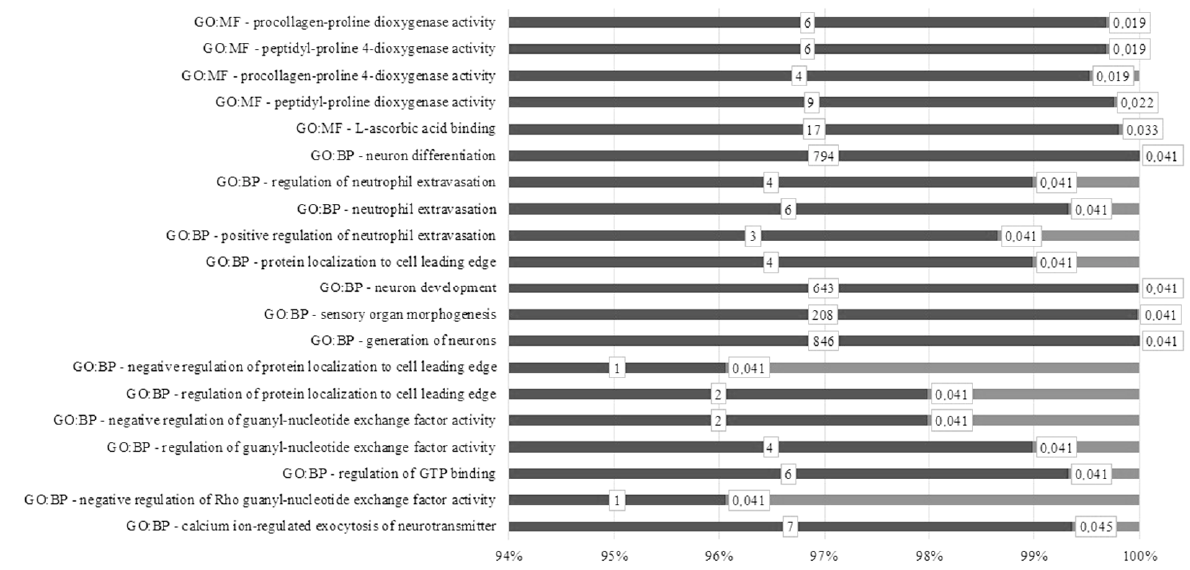
Figure 6. Gene ontology (GO) analysis for discovered candidate genes in Jalgin merino. GO:MF: Figure molecular function; GO:BP: biological process. Light grey: adjusted p -value; dark grey: term size.